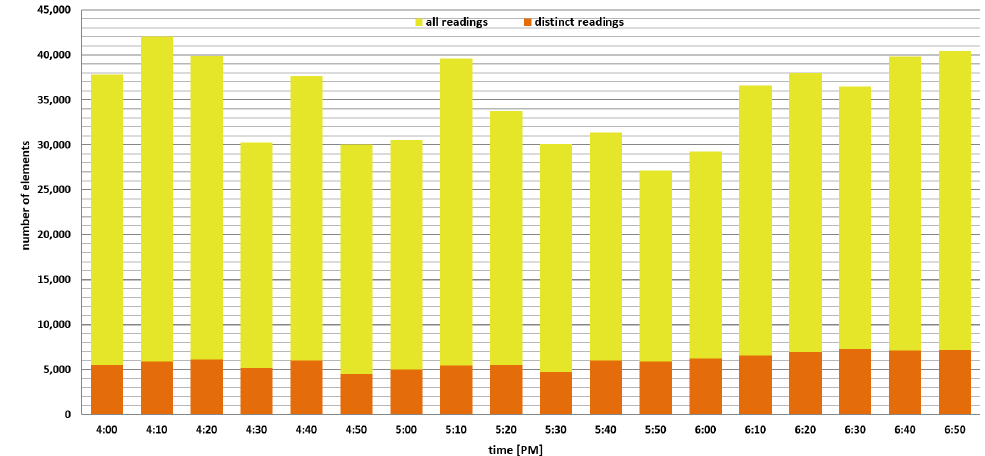
Figure 4. Ratio between all and distinct data readings in the period from 4 p.m. to 6:50